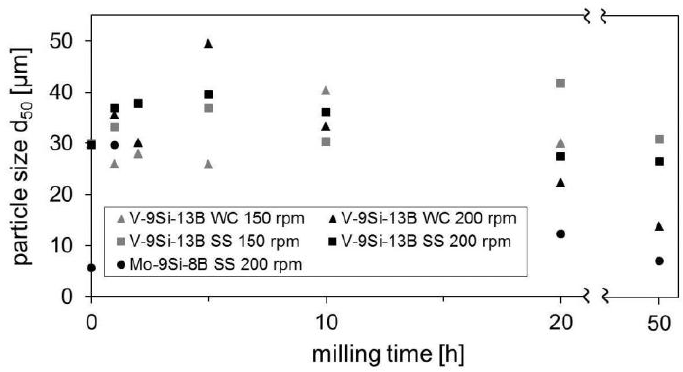
Figure 4. Particle size ( d 50 ) of V-9Si-13B and Mo-9Si-8B powders depending on the milling time.